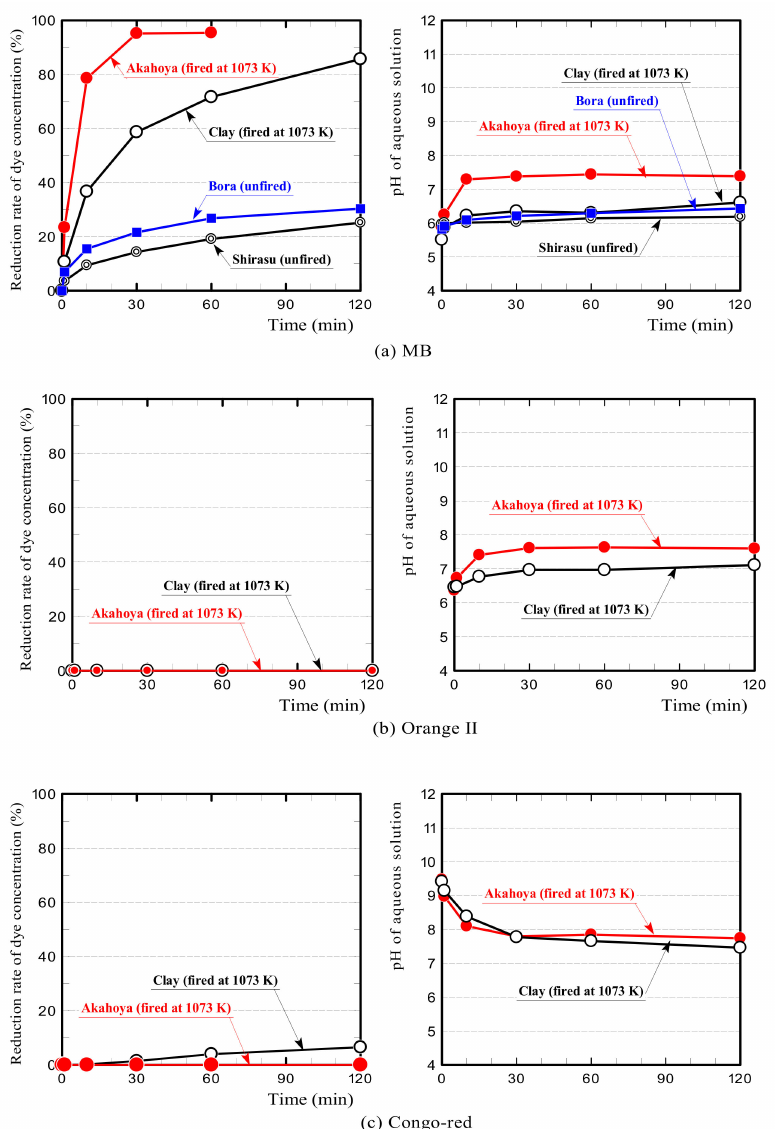
Figure 13. Dye concentration reduction rates of samples and temporal change in pH of the dye solution: ( a ) MB, ( b ) Orange II, and ( c ) Congo